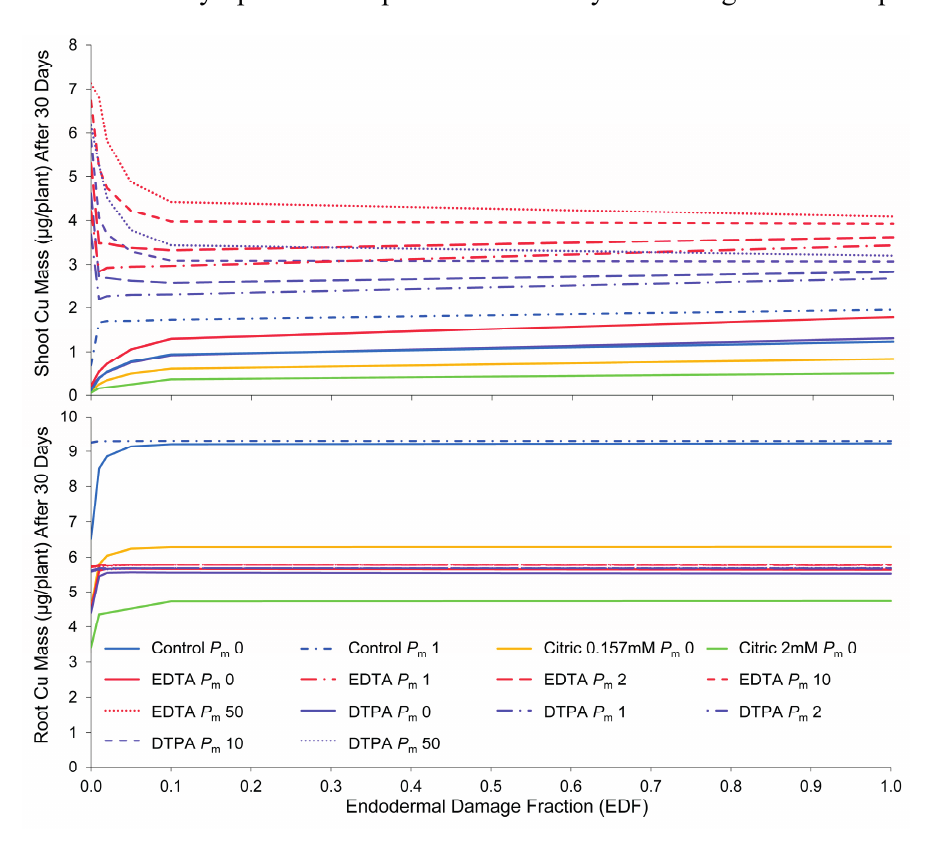
Figure 2. Influence of endodermal damage on simulated Cu accumulation by root and shoot tissue in control and chelator treatments, with P m indicating varying levels of